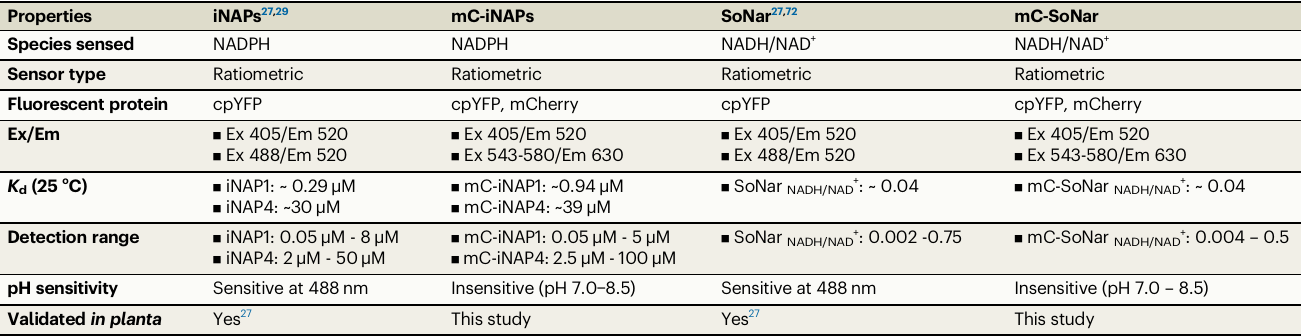
Table 1 | Properties of the fi rst- and second-generation iNAPs and SoNar biosensors